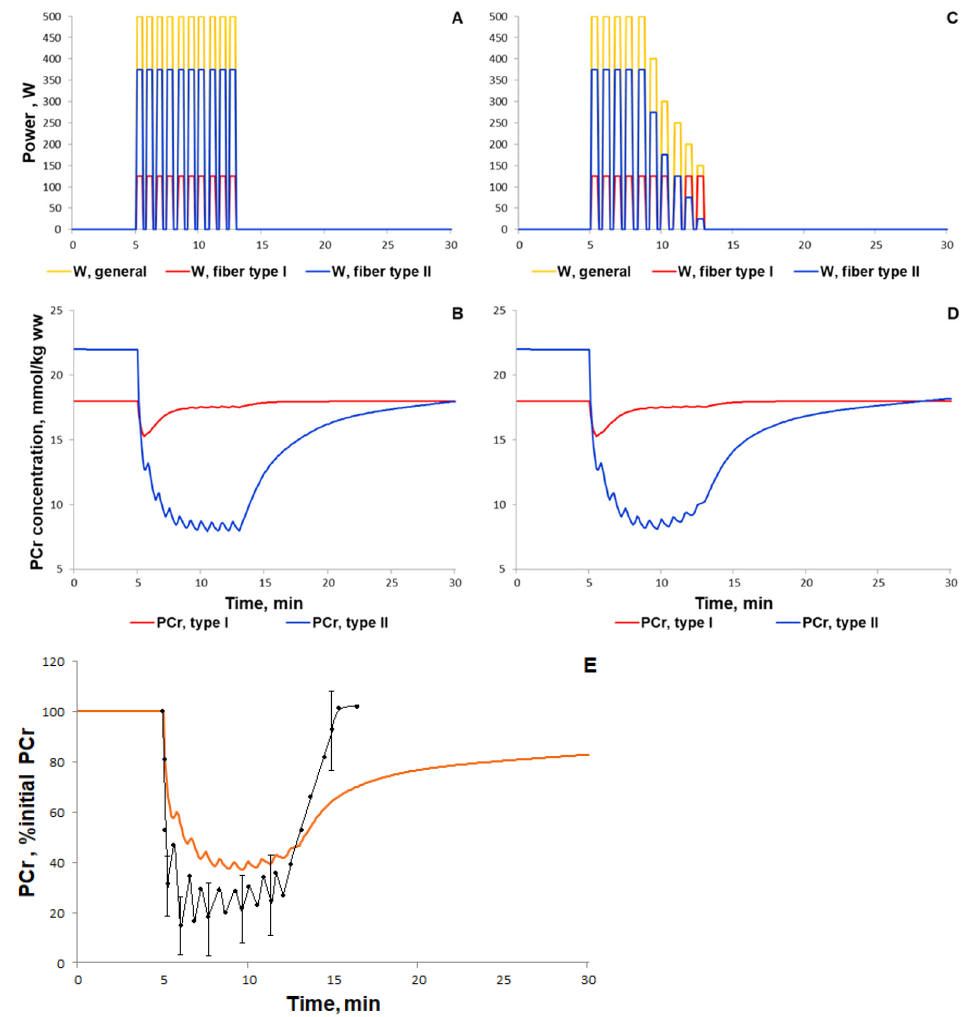
Figure 10. Simulation results for high-intensity intermittent exercise (each bout of 30 s exercise sep-